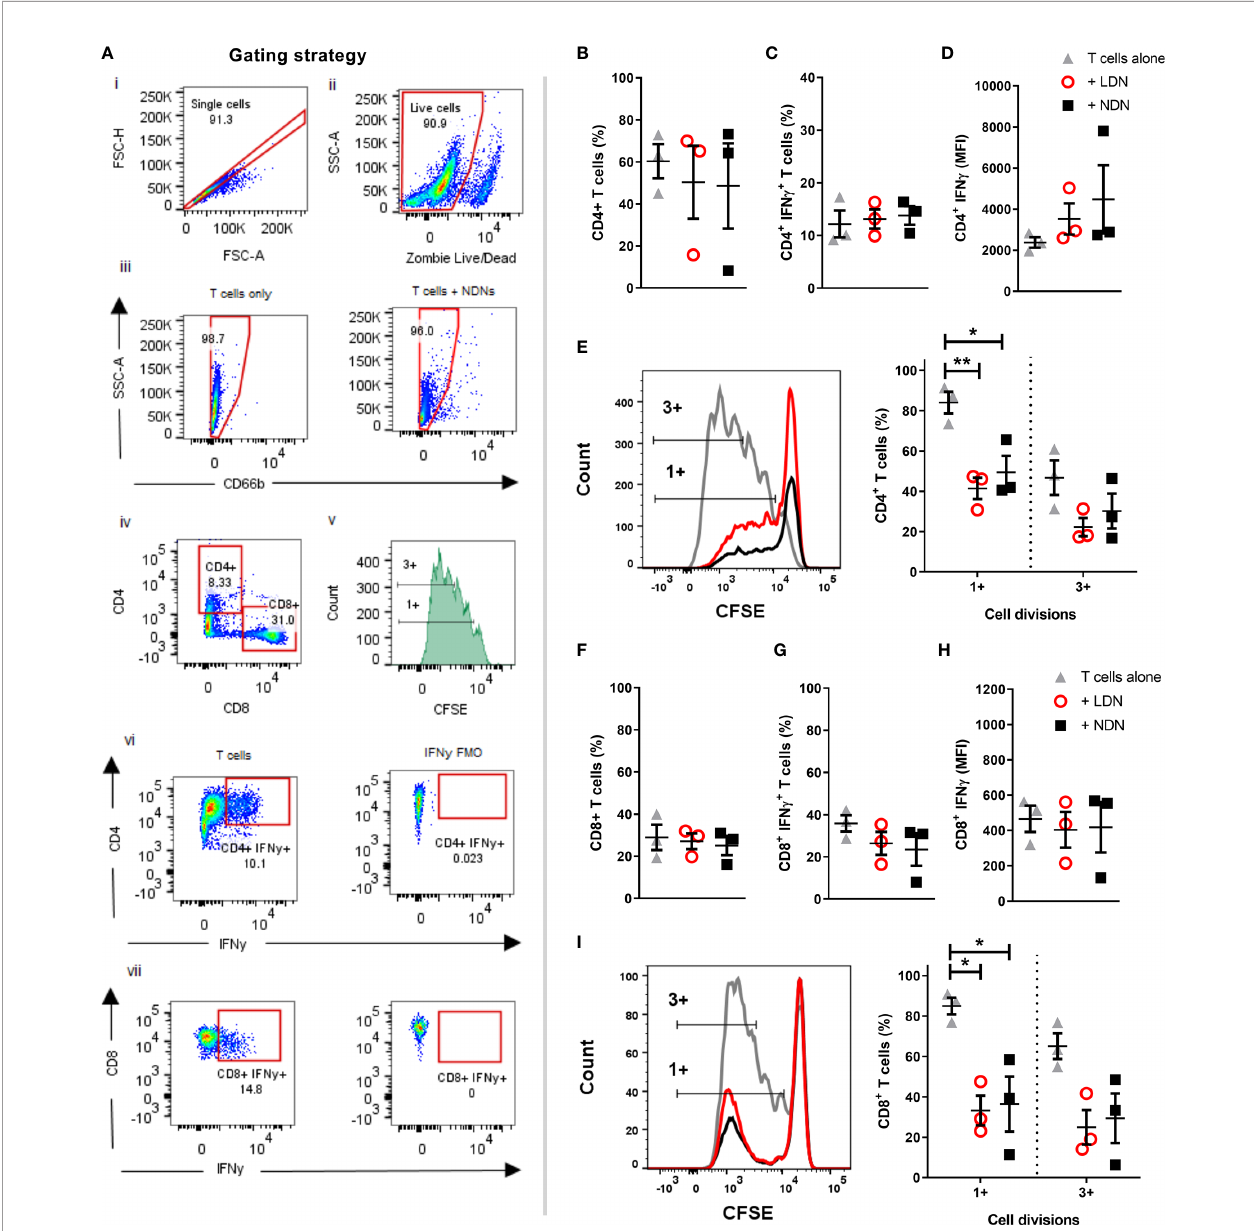
FIGURE 4 | Co-culture of T cells with either LDNs or NDNs reduces T cell proliferation (A) Gating strategy to identify T cells after 96 hour co-culture with neutrophils. (B) Percentage of CD4+ T cells in culture after 96 hours (N=3). (C) Percentage of CD4+ T cells producing intracellular IFN- g after 96 hour co-culture with neutrophils then 4 hour stimulation with T cell activation cocktail (N=3). (D) Amount of intracellular IFN- g production in CD4+ T cells, shown as mean fl uorescence intensity (N=3). (E) CD4+ T cell proliferation, measured by reduction in peaks of CFSE fl uorescence (N=3). (F) Percentage of CD8+ T cells in culture after 96 hours (N=3). (G) Percentage of CD8+ T cells producing intracellular IFN- g after 96 hour co-culture with neutrophils then 4 hour stimulation with T cell activation cocktail (N=3). (H) Amount of intracellular IFN- g production in CD8+ T cells, shown as mean fl uorescence intensity (N-3). (I) CD8+ T cell proliferation, measured by reduction in peaks of CFSE fl uorescence (N=3). All data represented as individual values with mean ± SEM). Statistical testing by one way ANOVA with multiple comparisons, where *p<0.05 and